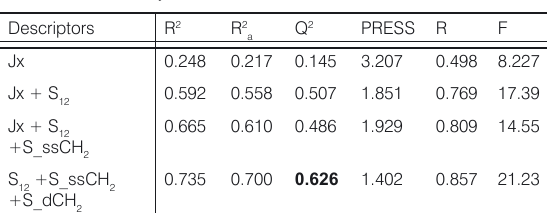
Table 2. Statistical qualities on gradual addition of descriptors in stepwise regression for lipid peroxidation inhibition po- tency of